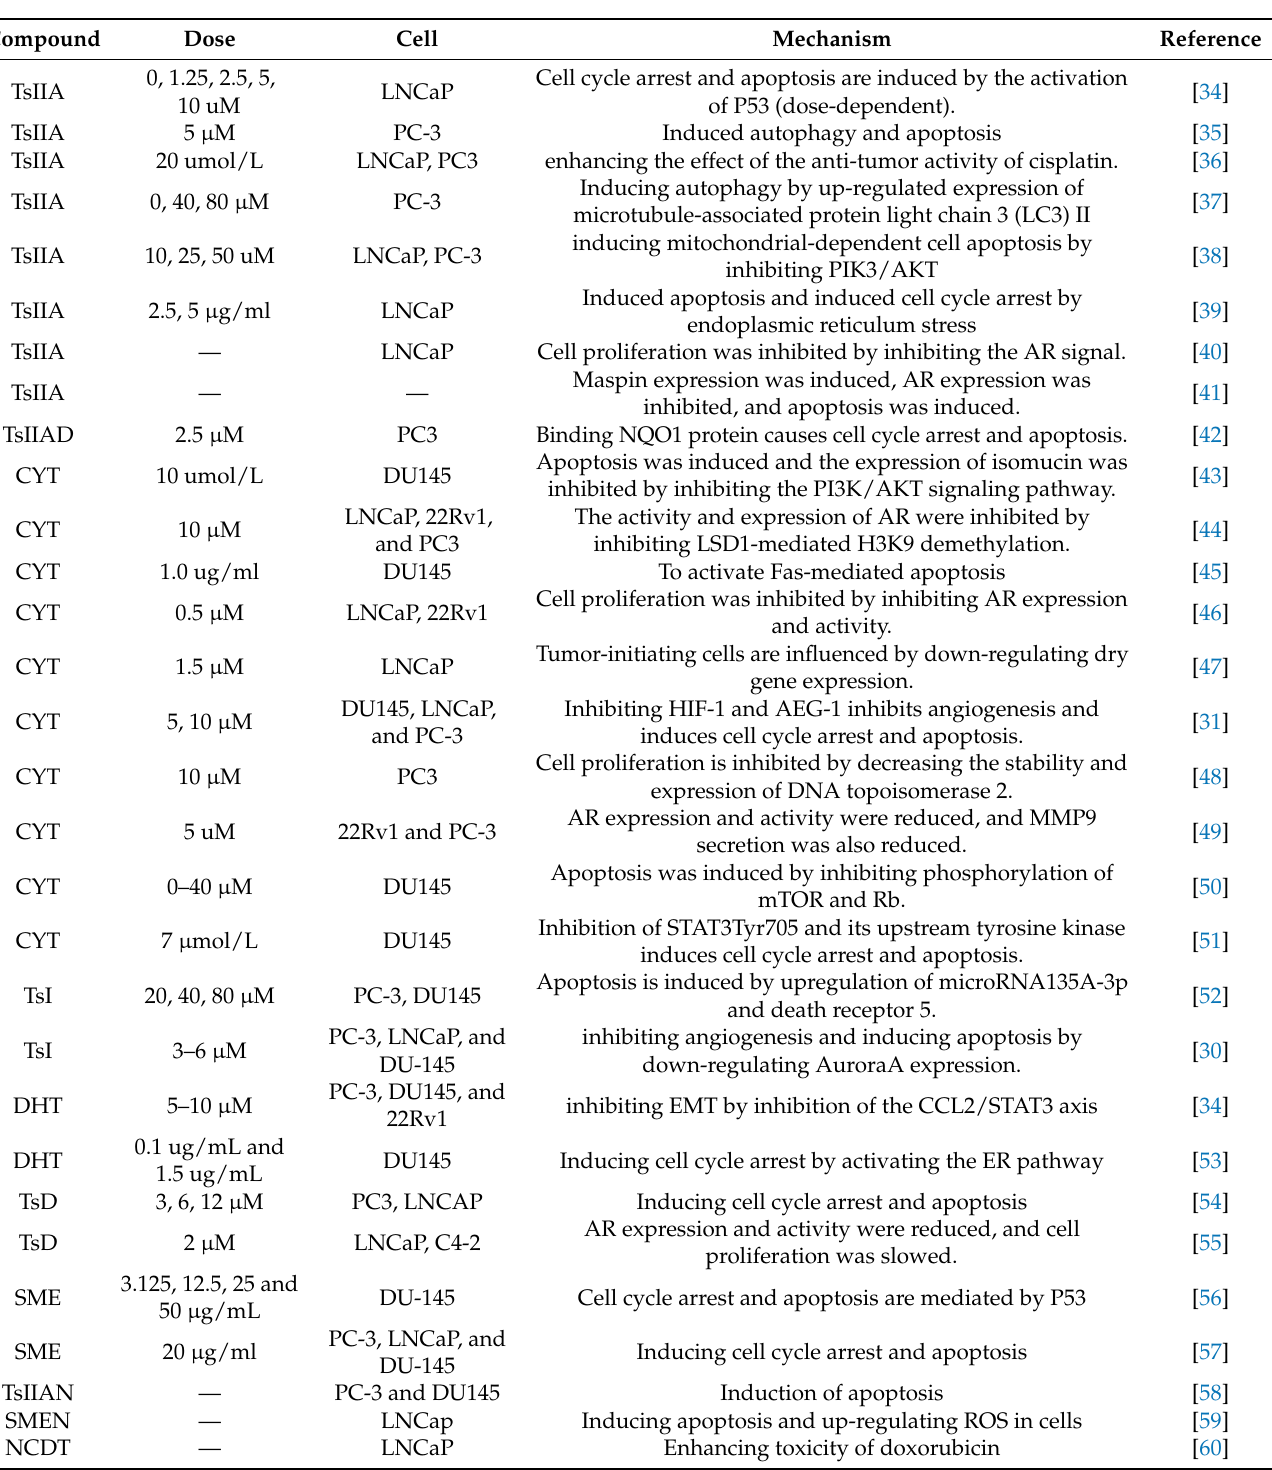
Table 2 summarizes the current state of Tanshinone and PCa in vivo research. Table 1. Tanshinone and PCa in